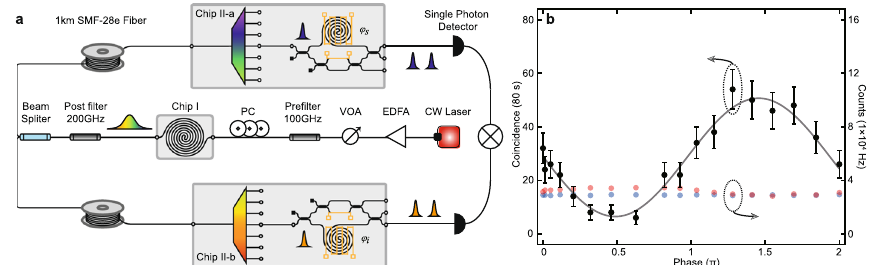
Fig. 4 Experimental setup of multi‑channel entanglement distribution of one sender and two receivers. a Experimental setup. A silicon‑on‑insulator waveguide on Chip I serves as a quantum source. Chip II‑a and Chip II‑b are energy‑time entanglement preparation and analysis chips, which serve as the receivers. Standard single mode fibers with one‑kilometer length connect the chips b The raw coincidence of the central peak for CH11&CH7 versus phase. The black dots are measured coincidences. The gray curve is obtained by fitting the measured results using the sine function. The error bar comes from the Poisson statistical distribution. Red and blue dots refer to single channel counts of idler and signal photons, respectively